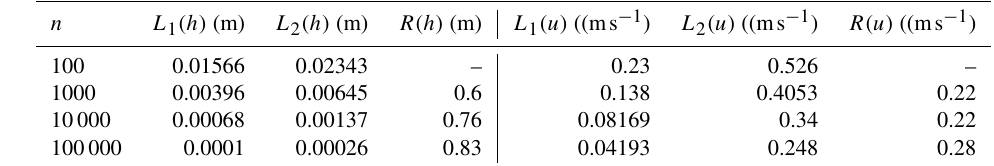
Table 3. Analytical dam break: L norms and empirical convergence rates ( R ) for water depth ( h ) and velocity ( u ).